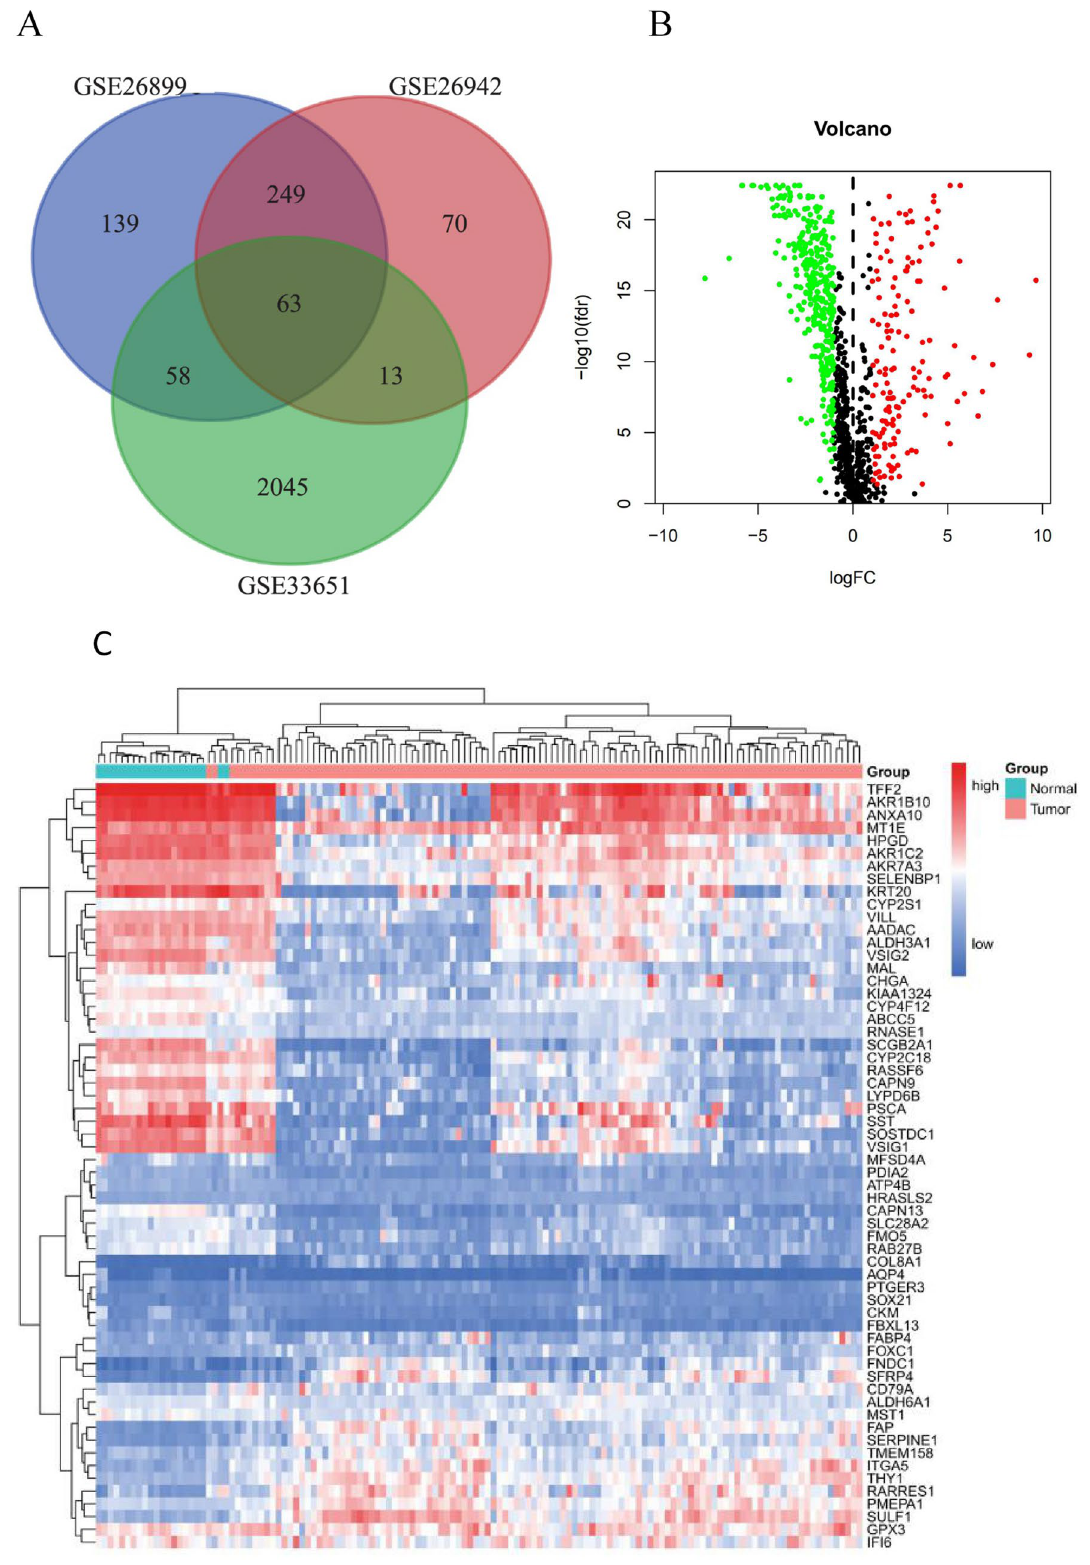
Figure 1. ( A ) The Venn plot of differentially expressed genes (drawn by VennDiagram R package 1.6.20, https:// CRAN.R- proje ct. org/ packa ge= VennD iagram); ( B ) Volcano map of differentially expressed genes (drawn by ggplot2 R package 3.3.2, https:// ggplo t2. tidyv erse. org/); ( C ) Clustering heatmap of differentially expressed genes (drawn by heatmap R package 1.1.9, https:// CRAN.R- proje ct. org/ packa ge= heatm